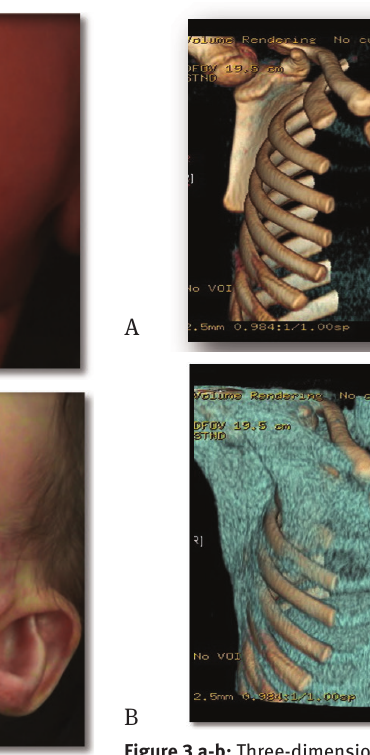
Figure 3 a-b: Three-dimensional reconstruction of CT images